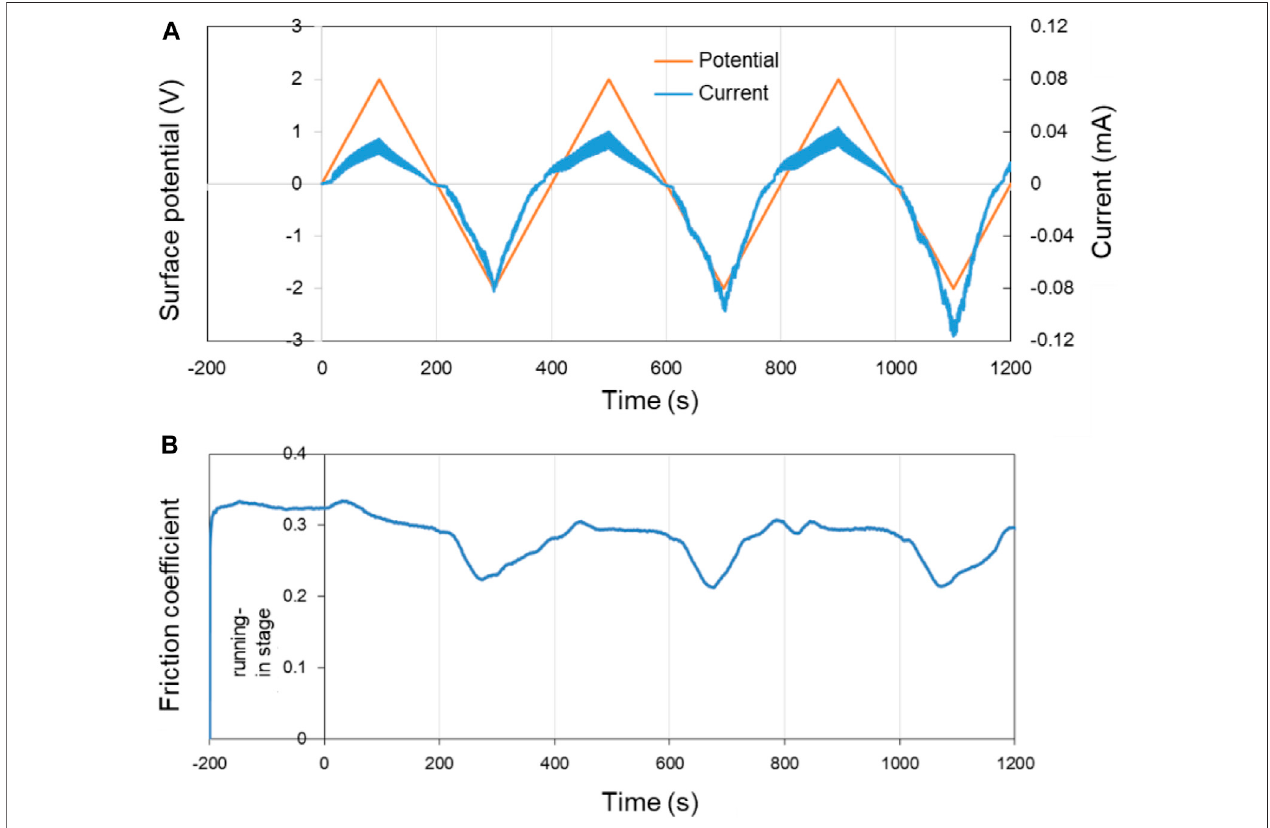
FIGURE8| Potential-controlledfrictionresultsoftheCuplatevs.ZrO 2 ballwithpurePCaslubricantandtheCusurfacepotentialamong ± 2.0 V. (A) Thechangeof surface potential and current of Cu plate over time and (B) the variation curve of friction coef fi cient with time under the applied surface potentials in (A) .